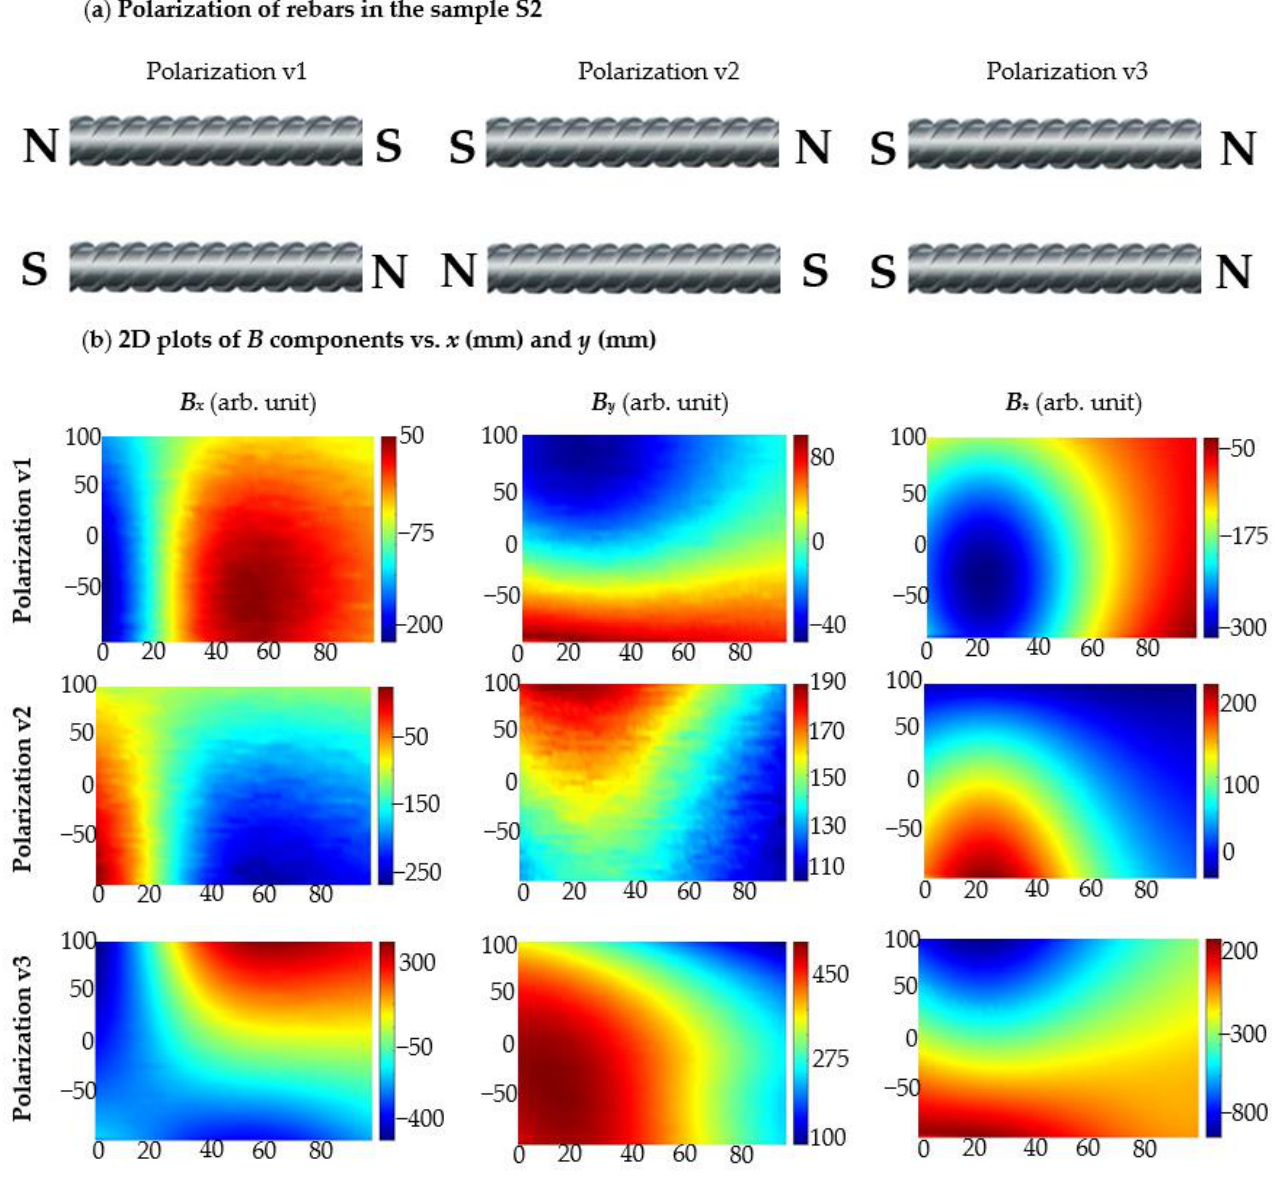
Figure 22. ( a ) Polarizations (residual magnetization) of earlier magnetized rebars in the sample S2; ( b ) Results of 2D measurements using AMR sensor received for different arrangements of earlier magnetized rebars; without external magnetization during measurements, the thickness of the concrete cover h = 40 mm; sample S2; x (mm), y (mm) — sensor positions.